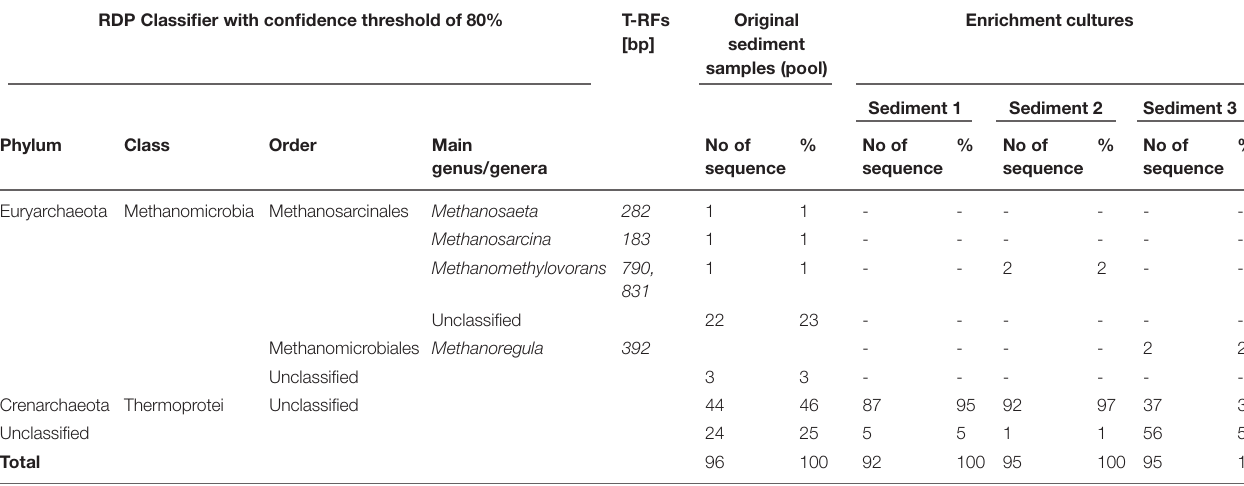
TABLE 3 | Phylogenetic affiliation of clone sequences produced via clone libraries of archaeal 16S rRNA gene fragments retrieved from DNA extracted from unamended ligniteous coal-rich sediment and derived enrichment cultures (after 17 months of incubation) amended with n